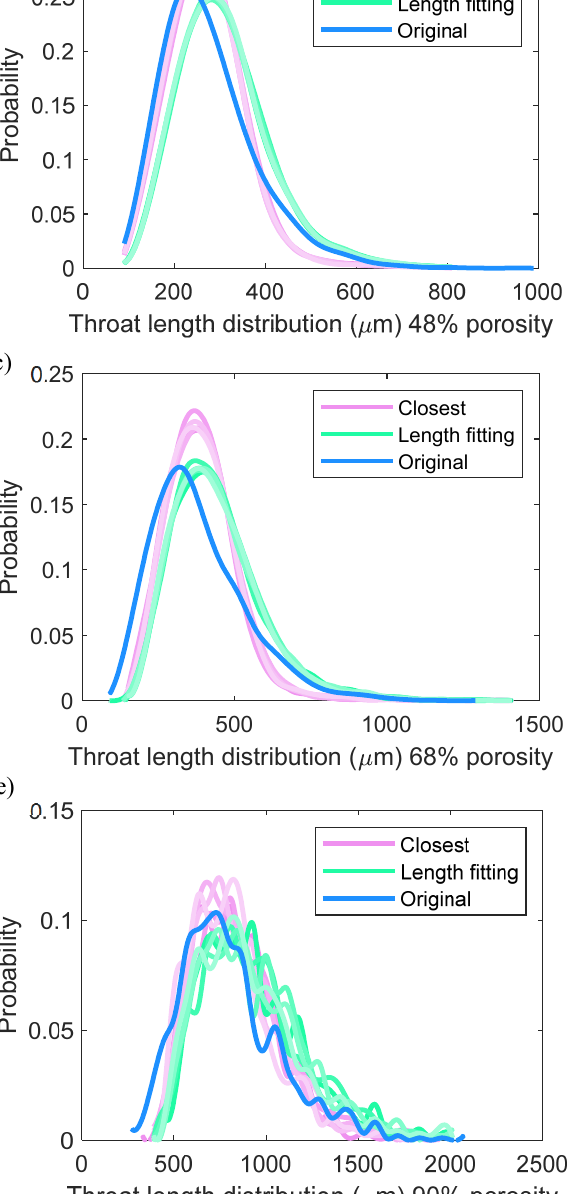
Figure 6. Figure 6. Comparison of throat length distributions using different generation rules (method I and method II) at different porosities ( a ) 48%, ( b ) 61%, ( c ) 68%, ( d ) 80%, and ( e ) 90%. The distributions generated using the closest neighbor rule (method II) and the length fitting rule (method I) are close to the original one, but neither of them can perfectly match the original one. For each method, five stochastic realizations are